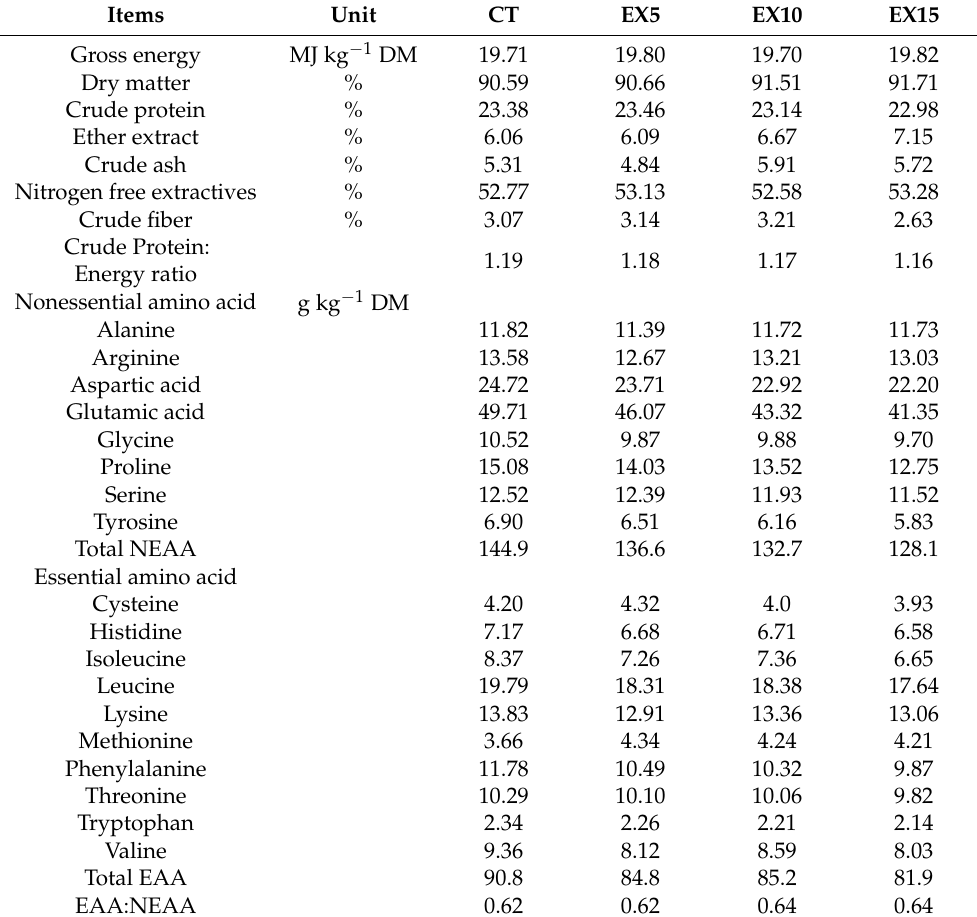
Table 3. Chemical composition of the experimental diets (applies to the finisher’s